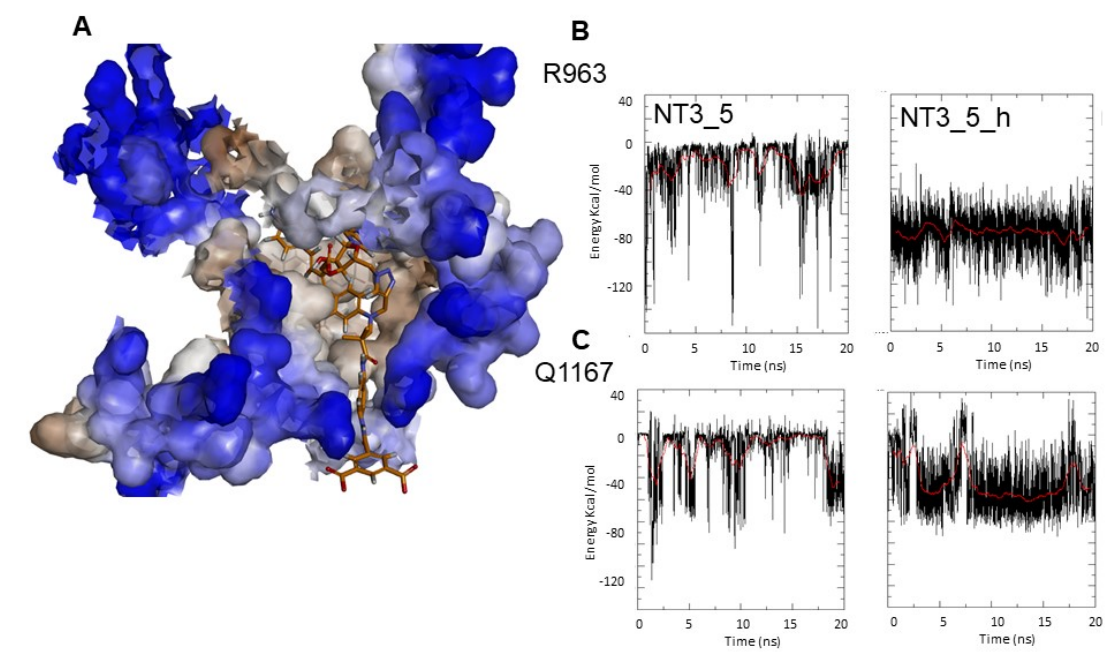
Figure 5. Targeting variable eNOS residues for selective binding. ( A ) Fit of NT3_5h into the NADPH site of eNOS represented in solvent surface view (using a probe radius of 1.5 Ǻ ) with the color code: hydrophylic blue and hydrophobic brown. The key interactions between the nanotrigger NT3_5h and eNOS are as follows: The NH2 terminal of NT3_5h formed an H-bond with D1158 and S941 stacked with the phenyl rings of the chromophore onto which adenine stacked. Extended interactions of P1014